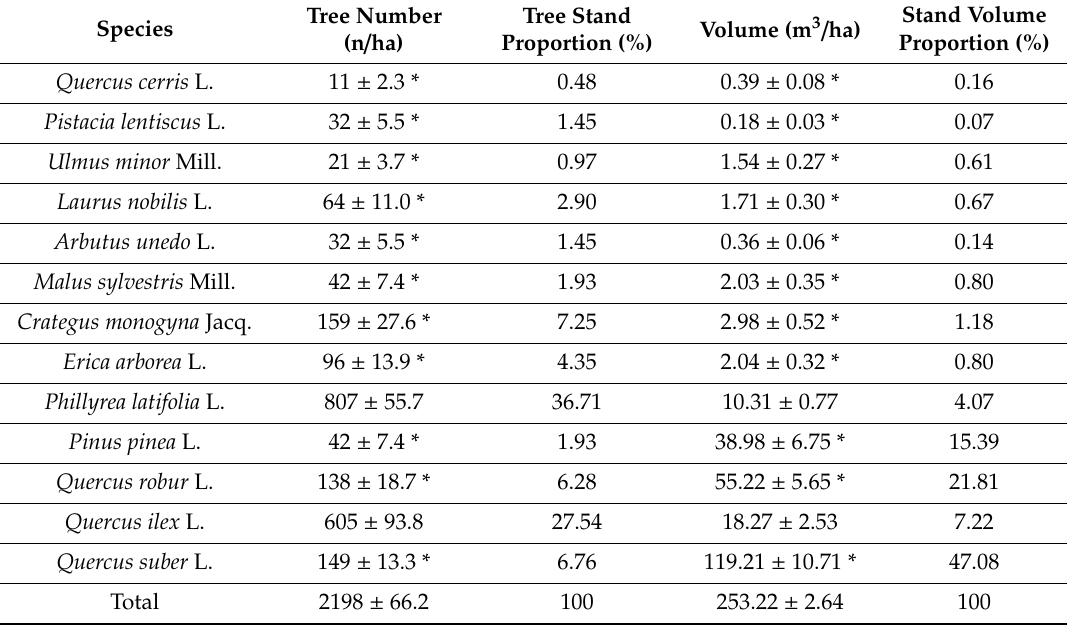
Table 4. Species’ composition and growing stock of living trees (mean ± standard deviation) in the evergreen oak forest. Stand Volume Tree Number Tree Stand Species Volume (m 3 / ha) Proportion (%) (n / ha) Proportion (%) Quercus cerris L. 11 ± 2.3 * 0.48 0.39 ± 0.08 * 0.16 Pistacia lentiscus L. 32 ± 5.5 * 1.45 0.18 ± 0.03 * 0.07 Ulmus minor Mill. 21 ± 3.7 * 0.97 Laurus nobilis L. Arbutus unedo L. Malus sylvestris Mill. Crategus monogyna Jacq.